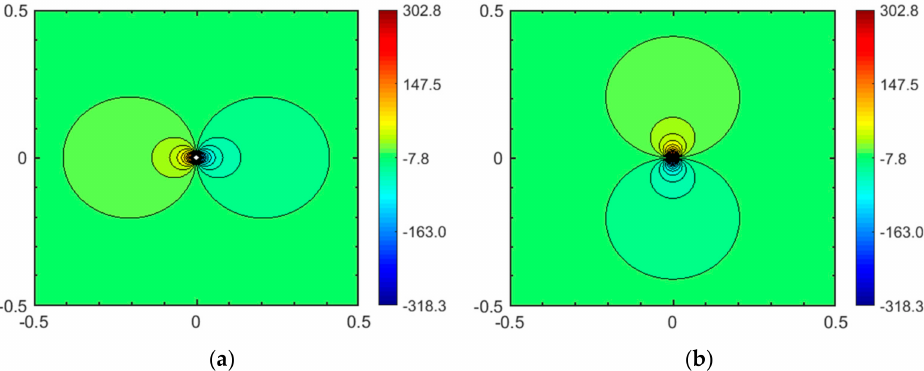
Figure 8. Potential function ( a ) and stream function ( b ) for singularity dipole. Strength of point dipole ( µ *) = 20 m 3 · s − 1 and z d = 0.